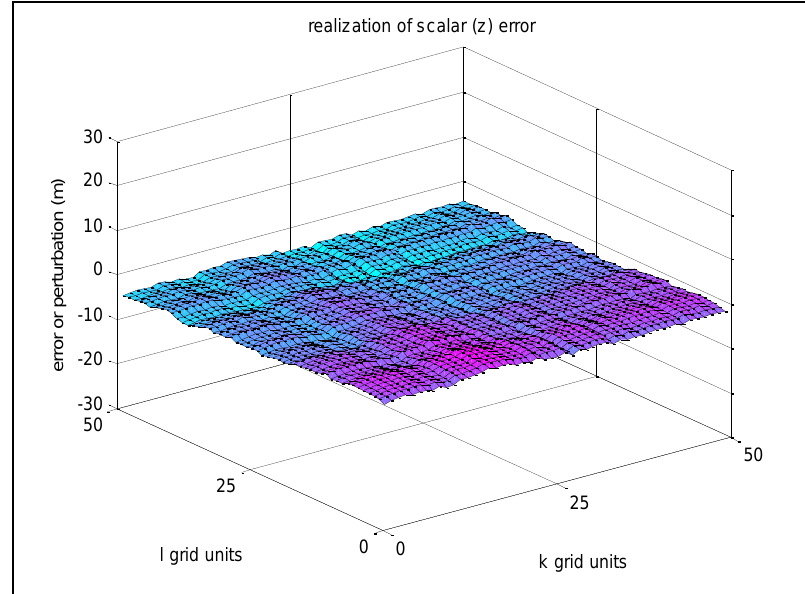
Figure 6. Example 3—Realization of -error with very high spatial correlation between adjacent grid